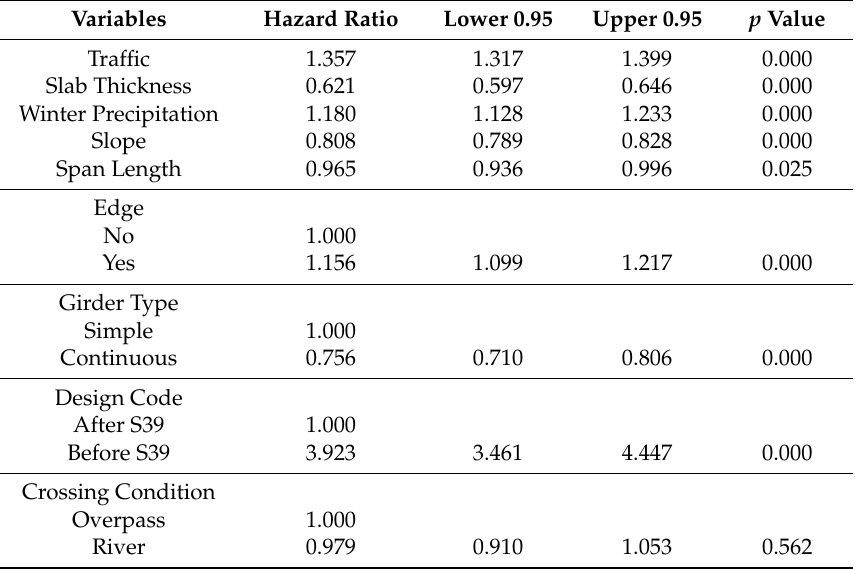
Table 7. Multivariate Cox regression analysis result of Tokyo region.